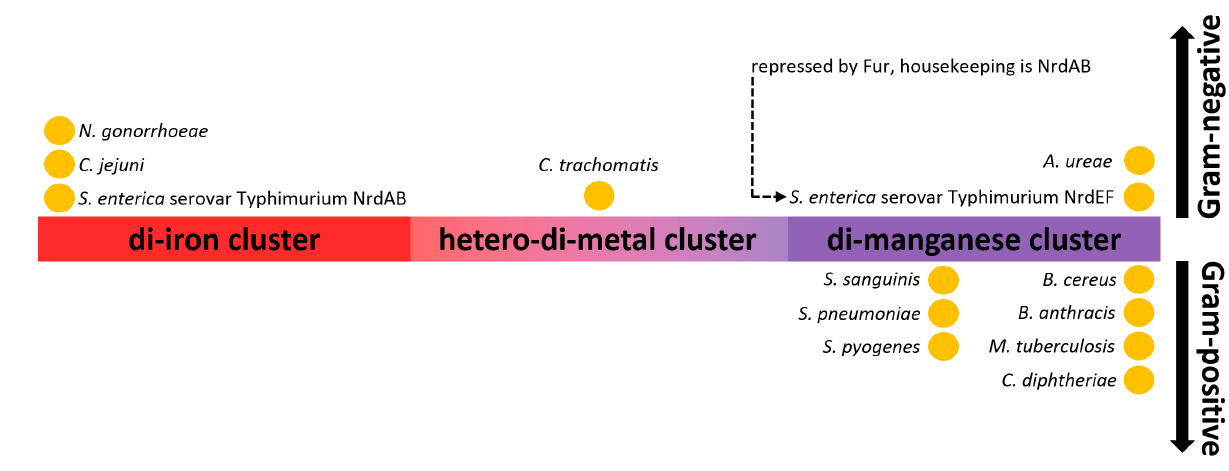
FIGURE 9 Distribution of class I RNRs based on their metal-dependency in pathogens. N. gonorrhoeae (Narasimhan et al., 2022), C. jejuni (Alqurashi et al., 2021), S. Typhimurium (Eriksson et al., 1998; Cotruvo and Stubbe, 2010; Panosa et al., 2010; Cotruvo and Stubbe, 2011; Martin and Imlay, 2011), C. trachomatis (Jiang et al., 2007), A. ureae (Rose et al., 2019), S. sanguinis (Makhlynets et al., 2014), S. pneumoniae (Jayachandran et al., 2021), S. pyogenes (Roca et al., 2008) , B. cereus (John et al., 2022), B . subtilis (Zhang and Stubbe, 2011) , B. anthracis (Gra ̄ ve et al., 2020) , M. tuberculosis (Hammerstad et al., 2014). Although the RNR of C . diphtheriae has not been directly characterized, it is very likely that it is manganese-dependent, as two close non-pathogenic relatives, C . glutamicum and C . ammoniagenes , have been demonstrated to be manganese-dependent RNRs (Abbouni et al., 2009; Cox et al.,